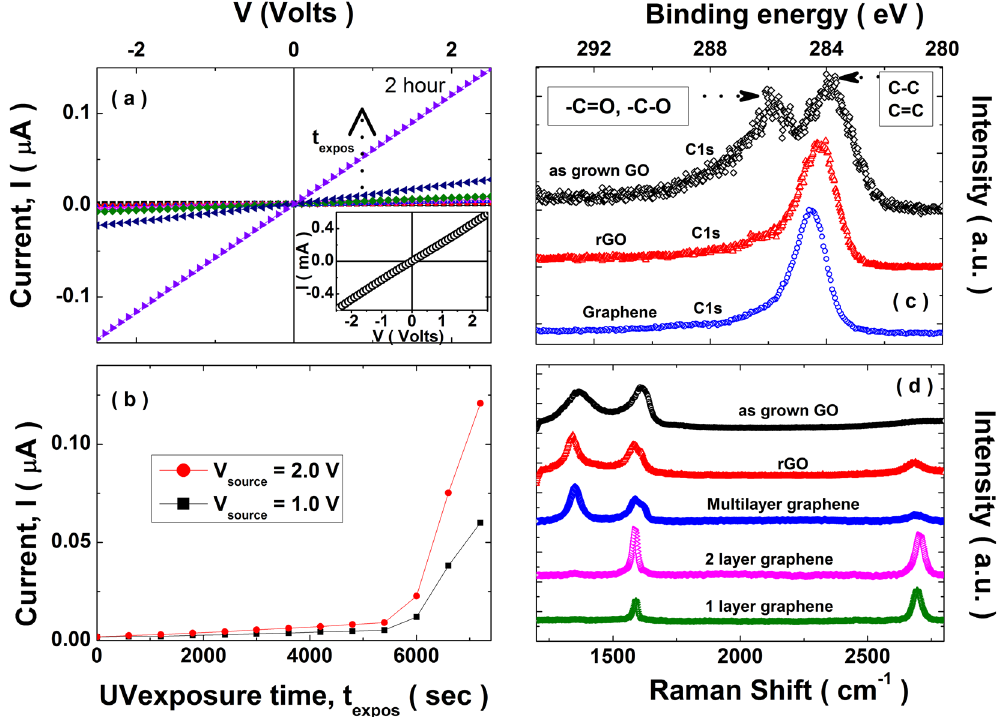
Figure 5. ( a ) The UV exposure dependent current-voltage (I-V) characteristics of a GO film drop-casted on a glass substrate. These I-V characteristics were obtained after different durations of exposure (ranging from 0–2 hour) to a 4 Watt, UV lamp emitting at 365 nm. Inset: I-V characteristics of CVD grown graphene, ( b ) Current (I) as a function of UV exposure time keeping the voltage (V) across the GO film fixed at 1.0 Volt and 2.0 Volt, respectively. ( c ) C 1 s XPS obtained for the GO and the rGO (reduced via exposure to a 4 Watt, 365 nm UV lamp for 2 hours) samples and that of CVD grown graphene. The peaks corresponding to the various functional groups are marked. ( d ) The comparison of Raman spectra for the GO film and the rGO film obtained after a 2 hour exposure to a 4 Watt, 365 nm UV lamp and Raman spectra of 1 L, 2 L and multilayer CVD grown graphene. The D, G and 2D peaks are appropriately